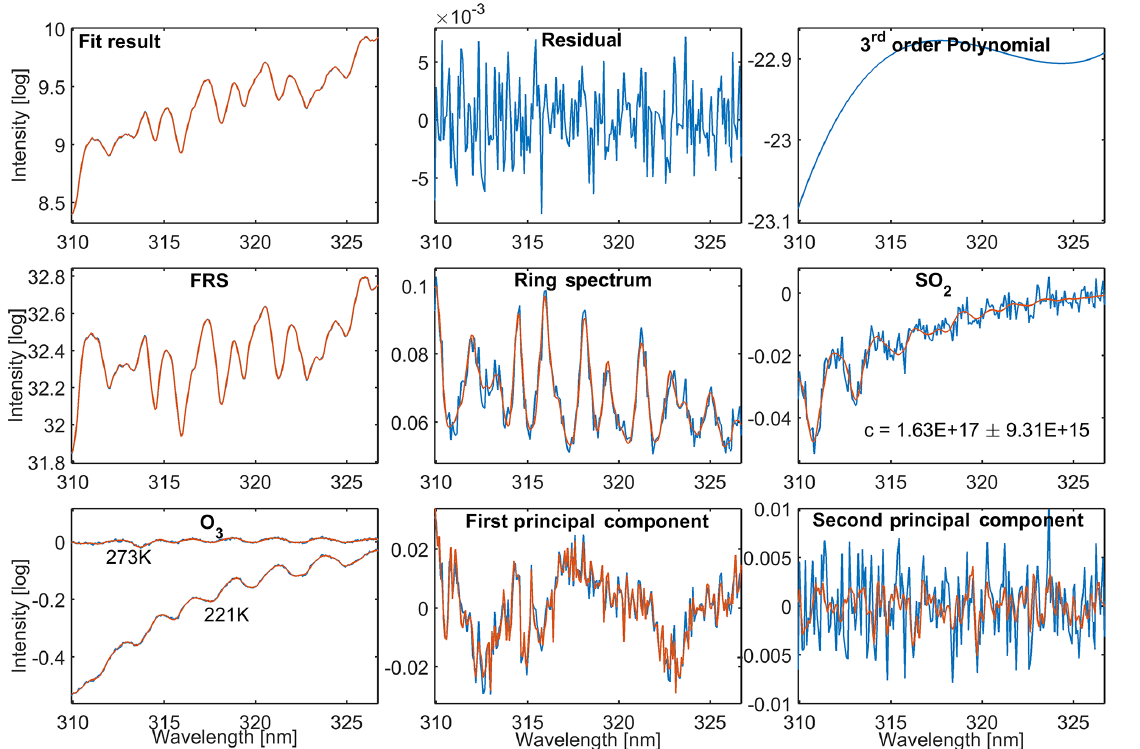
Figure 10. Example SO 2 DOAS fit of instrument D2J2201 (Nevado del Ruiz). The measurement spectrum was recorded on 5 March 2010 at 16:01 (UTC). The model functions are shown in red while the model + the residual (i.e. the measurement) are shown in blue.